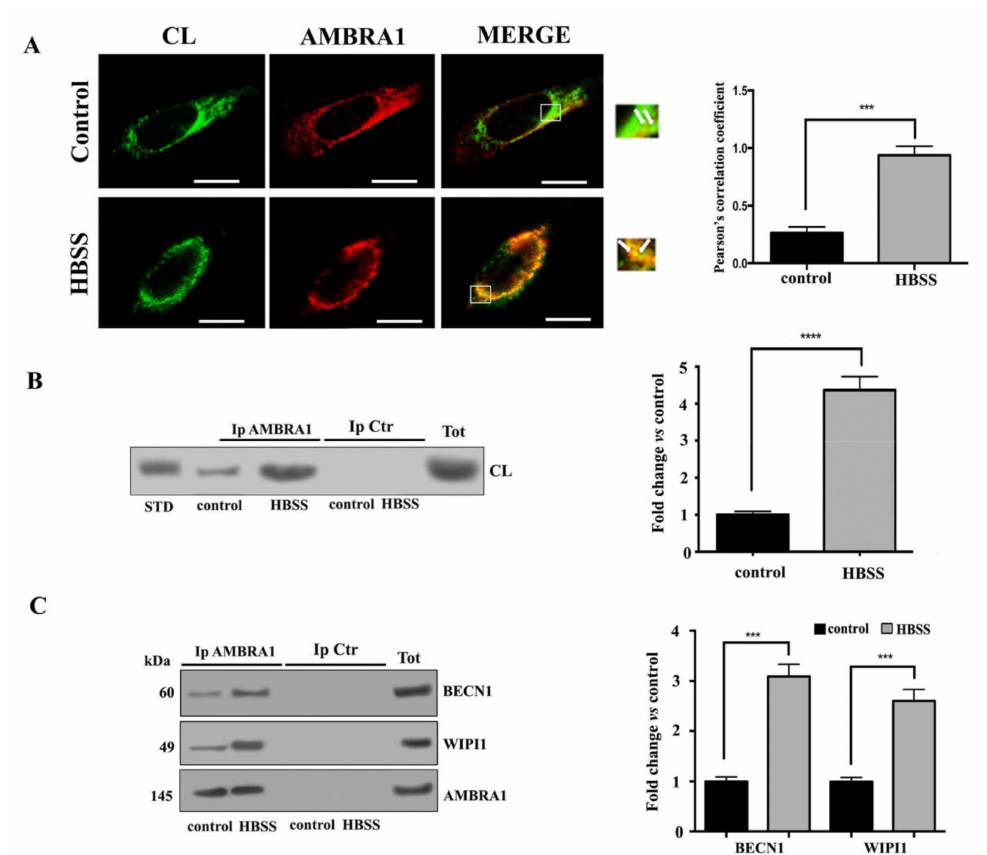
Figure 5. Cardiolipin/AMBRA1 association during autophagy induction in neuronal cells. ( A ) Analysis of CL/AMBRA1 co-localization during autophagy induction in SKNB-E-2 cells, either untreated or treated with HBSS 1 h, after double staining with anti-CL (green) and anti-AMBRA1 (red fluorescence). The images were acquired with Olympus FV1000 spectral